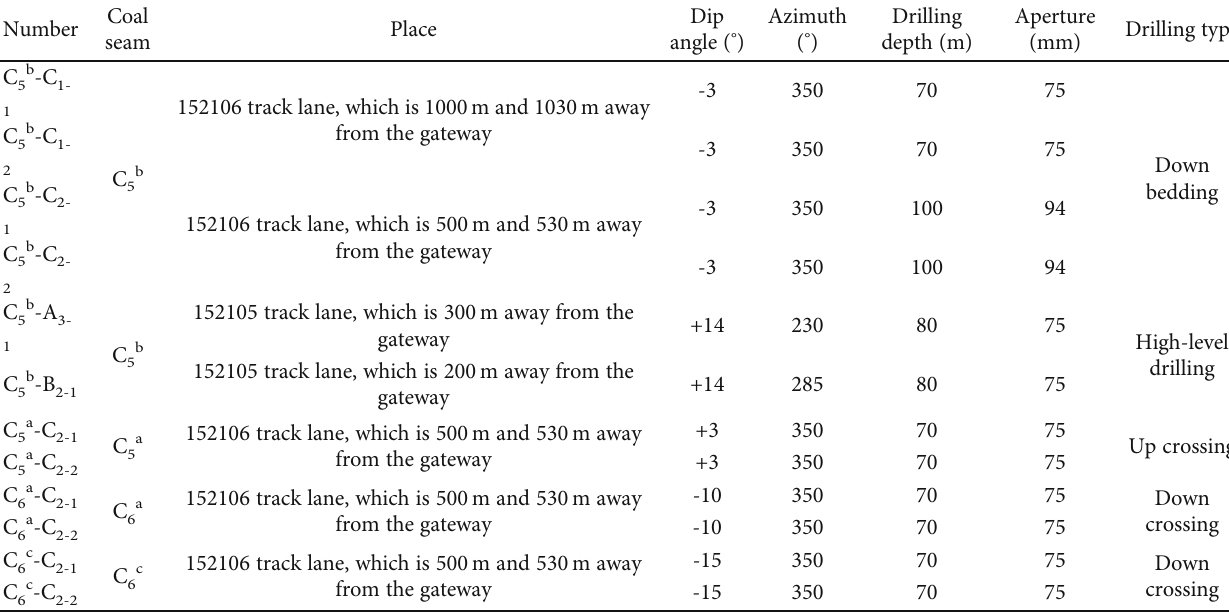
Table 2: Basic parameters of coal seam gas drainage